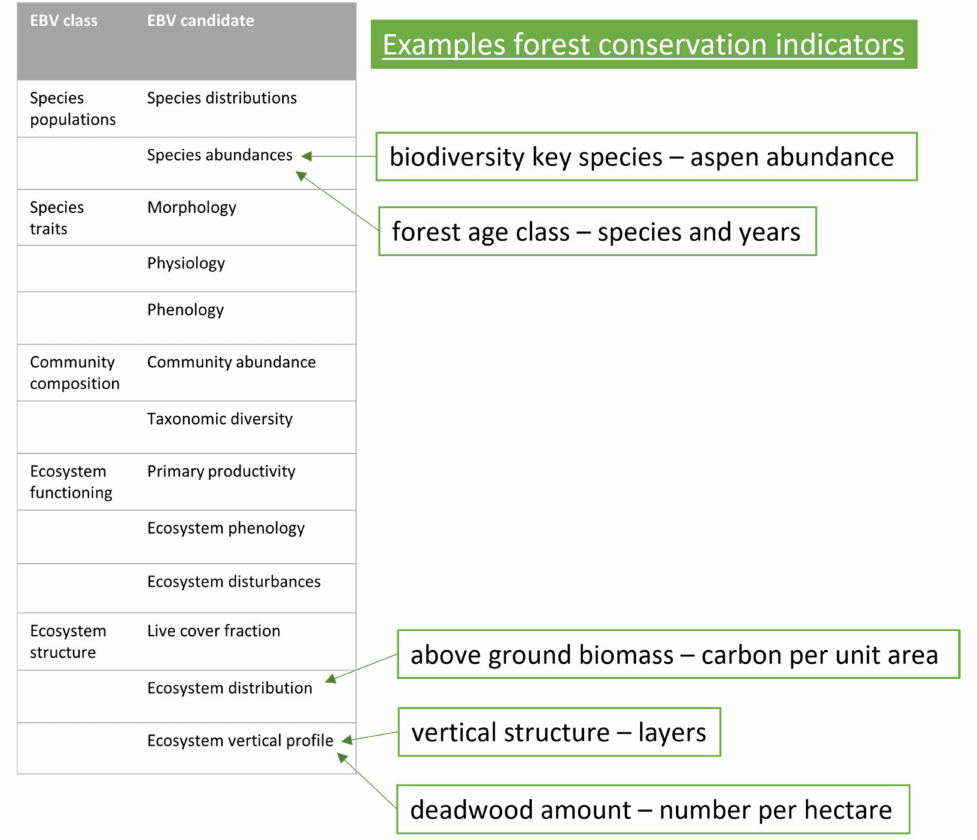
Figure 4. Examples of forest conservation indicators that may be linked with an EBV